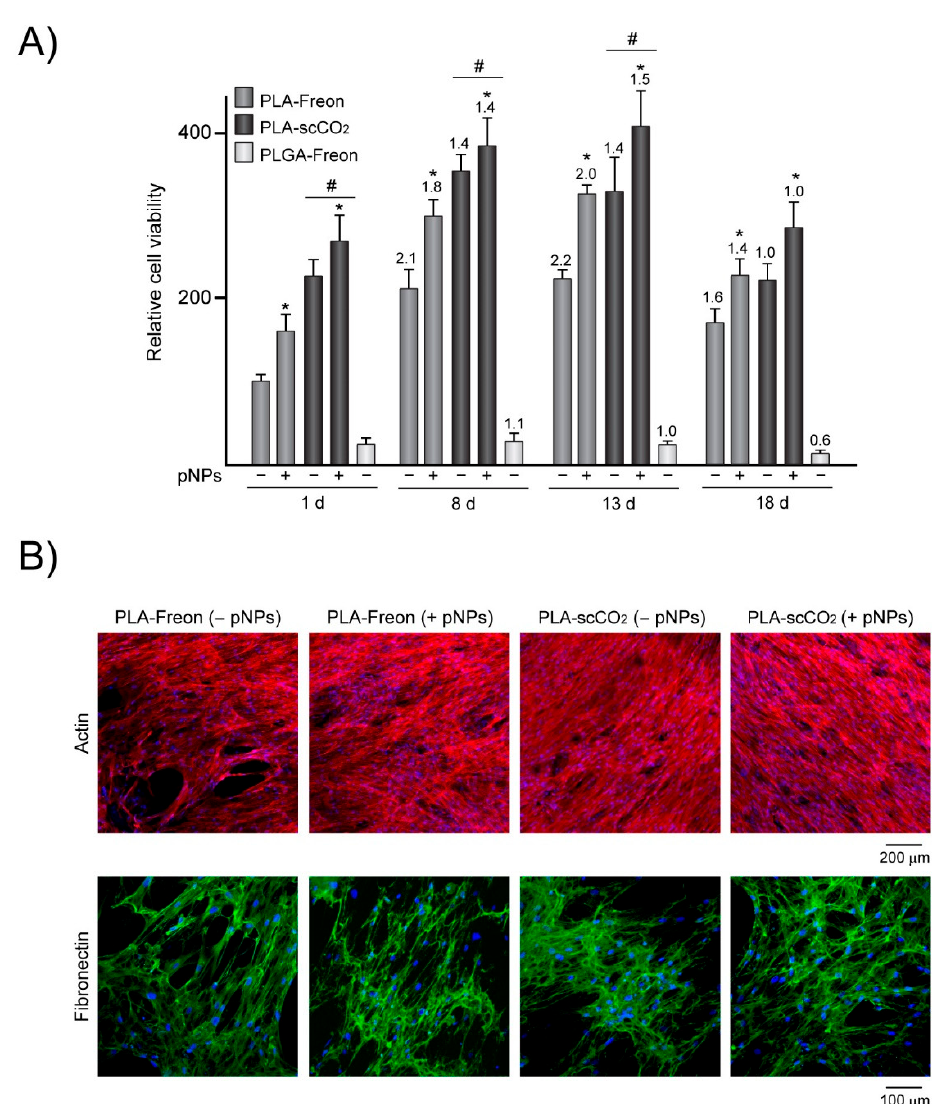
Figure 6. ( A ) Cell viability of MSCs cultured for 1–18 days on PLA processed with Freon R134a (PLA-Freon) or scCO 2 (PLA-scCO 2 ), decorated (+) or not ( − ) with pNPs, or on PLGA processed with Freon R134a (PLGA-Freon). The data were normalized relative to those measured in MSCs cultured for 1 day on PLA-Freon without pNPs, which were assigned an arbitrary value of 100. Fold-change values relative to cell viability at day 1 are shown above the graph bars. ( B ) Confocal maximum projections showing nuclei (blue), actin (red) or fibronectin (green) of MSCs cultured on the scaffolds for 8 days. * p < 0.05 compared with the scaffolds without pNPs. # p < 0.05 compared with PLA-Freon.